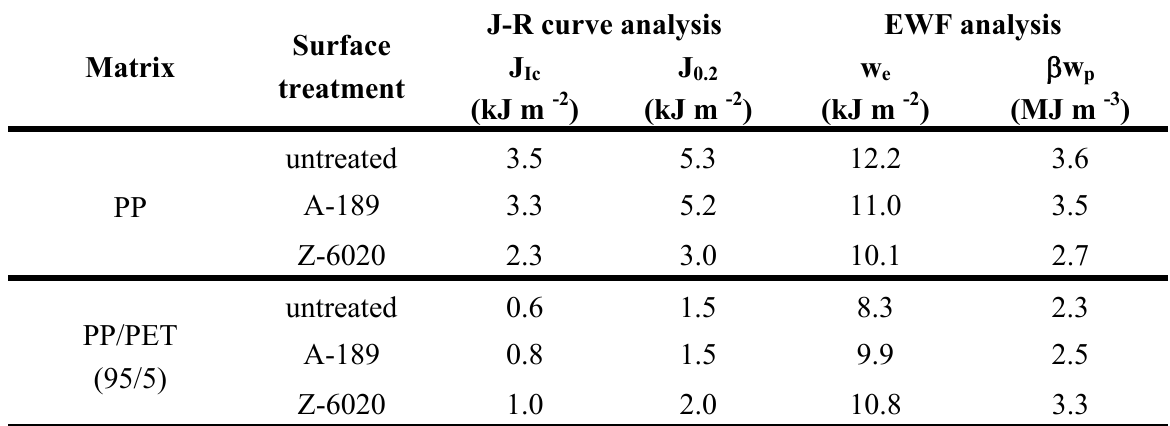
Table 2. J-R curve and EWF analysis of PP-glass bead composites with 26 vol.% of particles (data extracted from